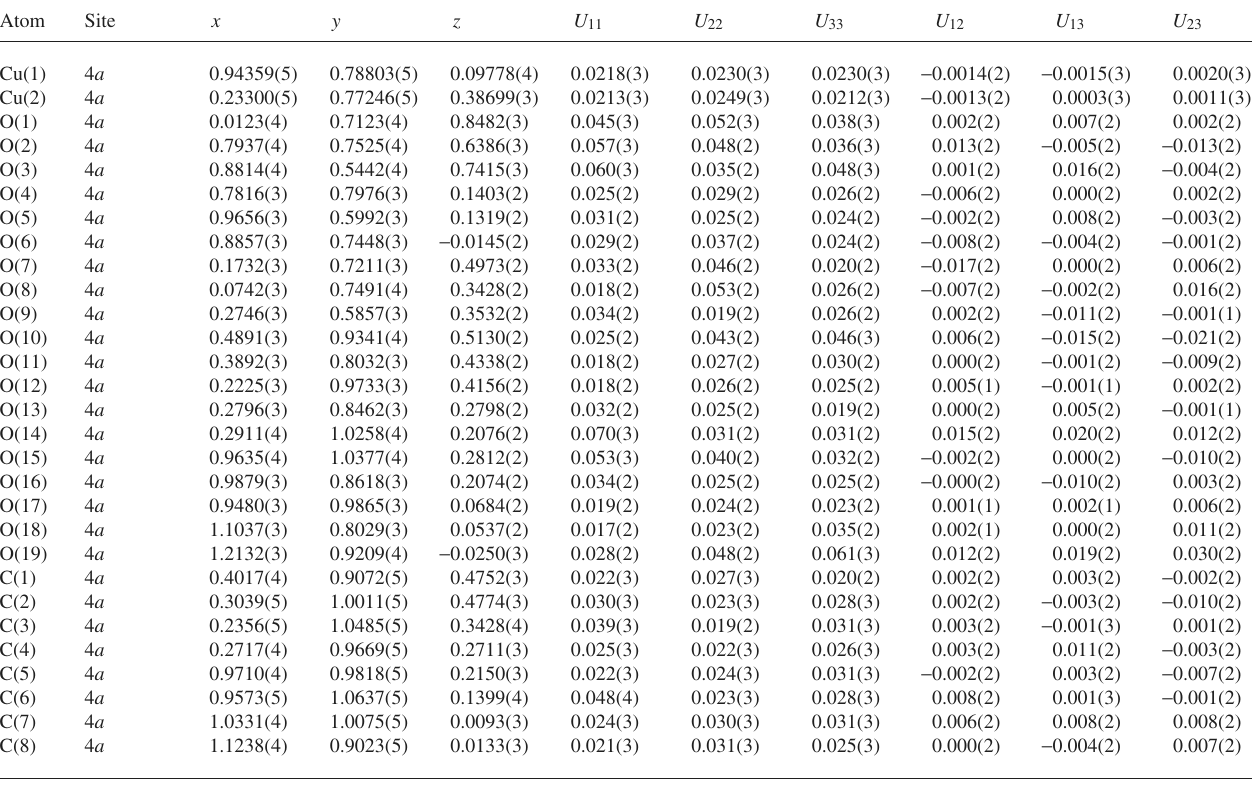
Table 3. Atomic coordinates and displacement parameters (in Å 2 )